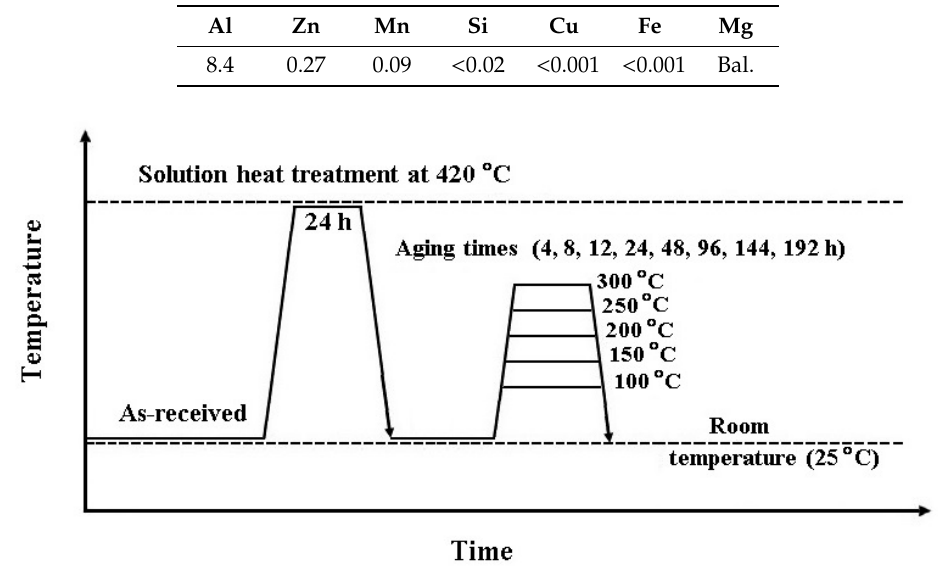
Figure 1. A schematic diagram showing the heat treatment procedure.